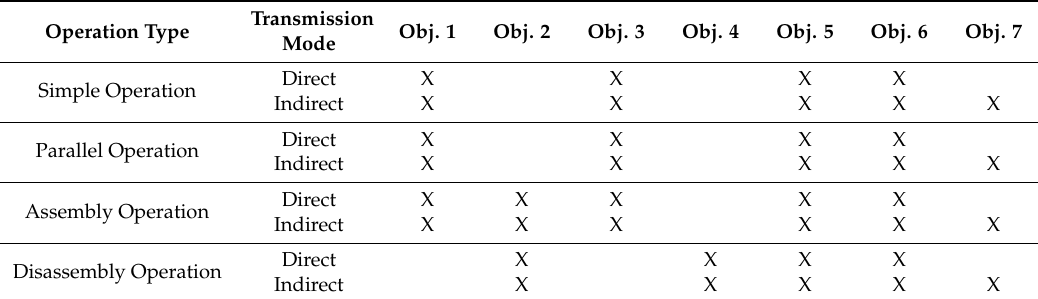
Table 1. Applied objects in the case of technological operations.